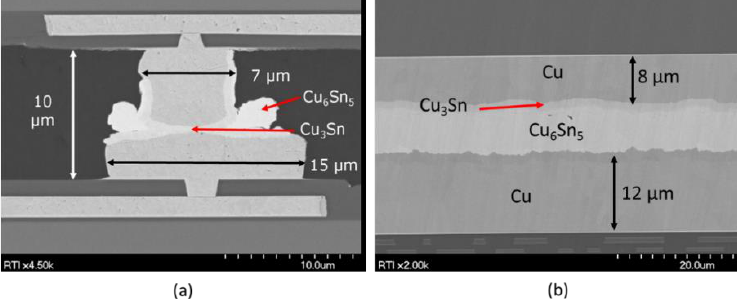
Figure 9. ( a ) Copper-Tin (Cu-Sn) SLID bonding used in integrated circuit (IC) interconnect bonding; ( b ) Cu-solid-liquid-interdiffusion (SLID) bonding used in the wafer-level vacuum packaging (WLVP) of infrared focal plane arrays.